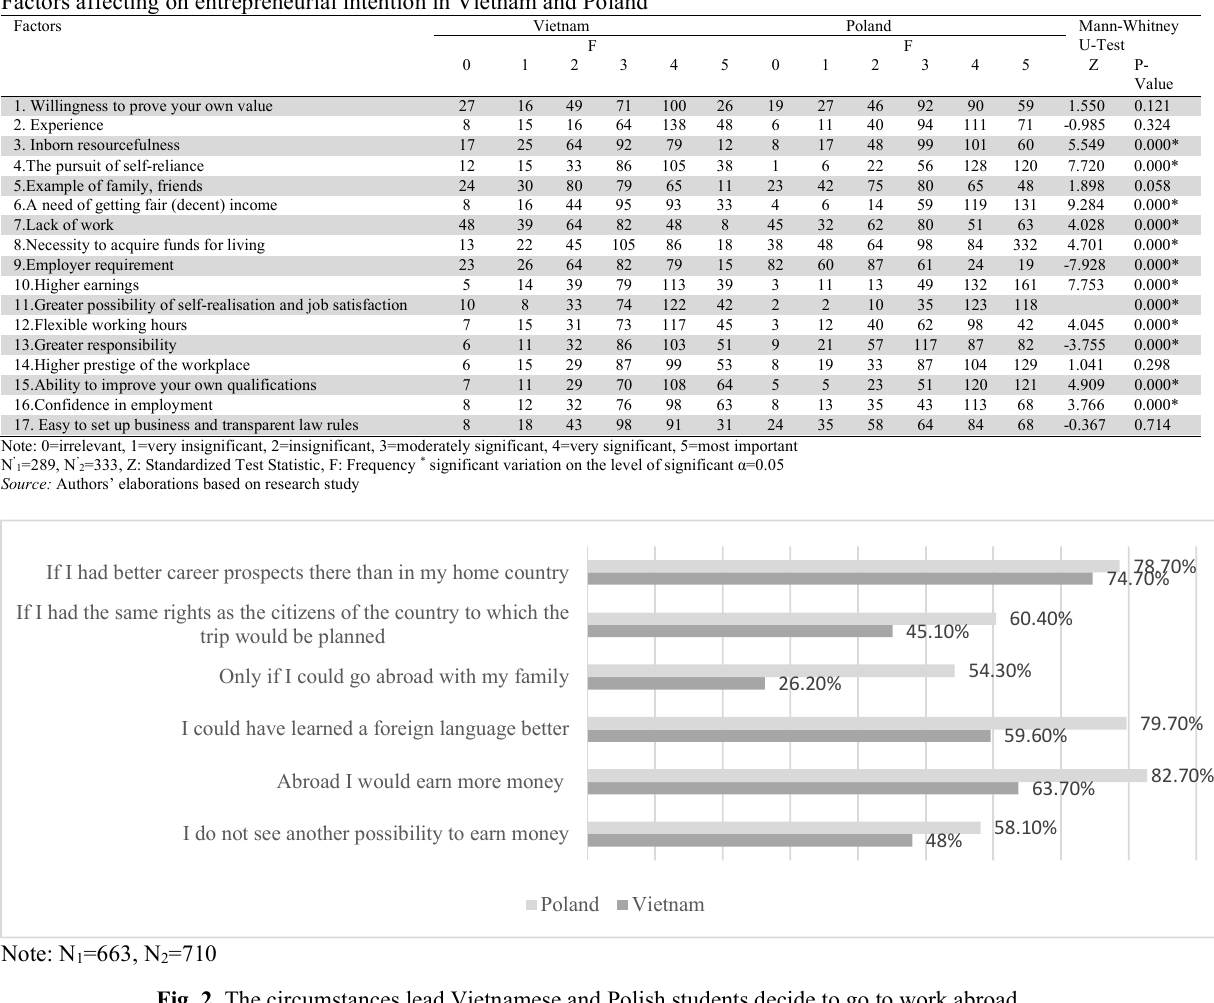
Fig. 2. The circumstances lead Vietnamese and Polish students decide to go to work